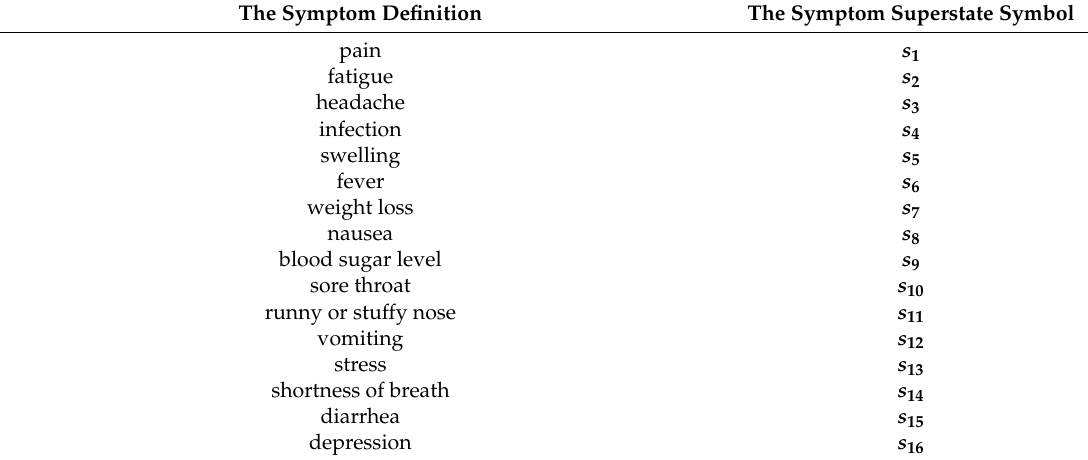
Table A1. Symptoms’